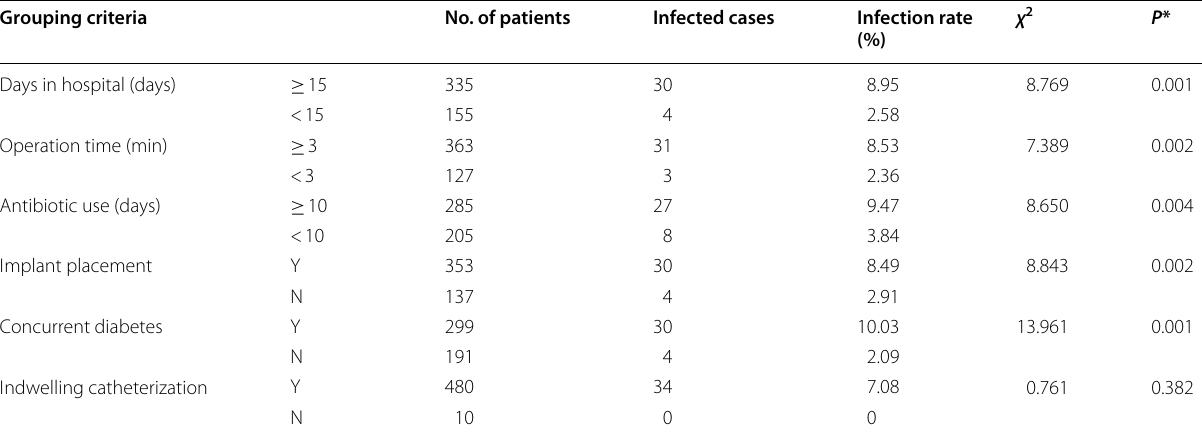
P * < 0.05 was considered to show a statistically significant difference